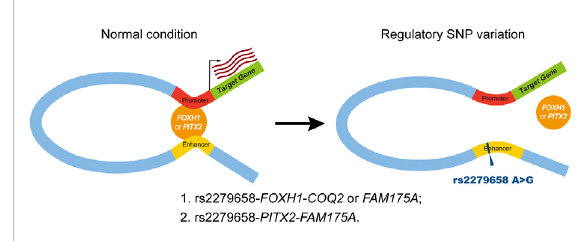
FIGURE 6 Schematic of the putative working model for cis -regulatory SNP rs2279658 in complex VSD pathogenesis. Left panel (normal condition), the cardiac-speci fi c enhancer carrying the protective allele rs2279658-A has known motifs for FOXH1 and PITX2 , resulting in high-af fi nity binding of FOXH1 and/or PITX2 , which makes this enhancer active in regulating its target genes via chromatin looping. Right panel (regulatory SNP variation), the cardiac-speci fi c enhancer harboring the risk allele rs2279658-G has disrupted FOXH1 - and PITX2 -binding motifs, thereby weakening the interaction between this enhancer and promoters of target